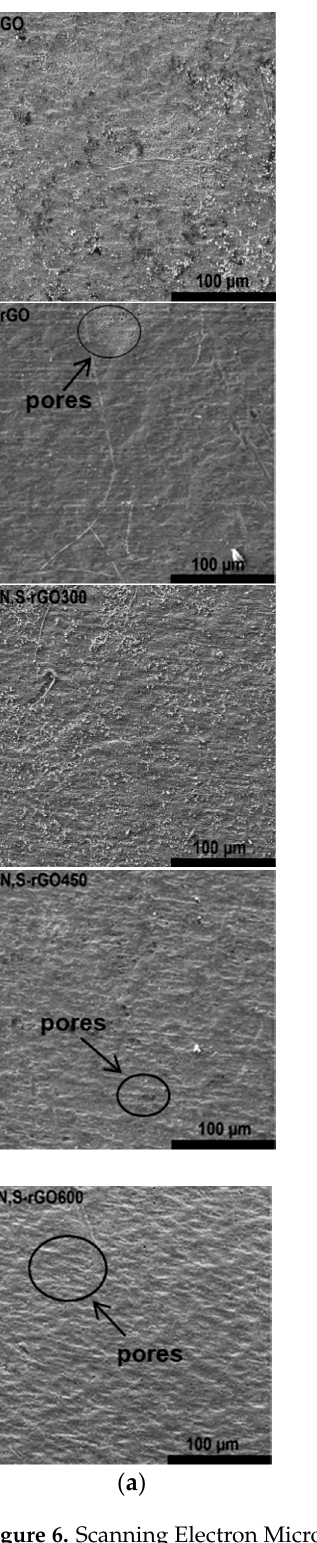
Figure 7. The thickness of graphene coatings. ( a ) ( b ) Figure 8. Photographs of graphene coatings: ( a ) after cross-cut test; ( b ) view of tape after breaking from coatings.